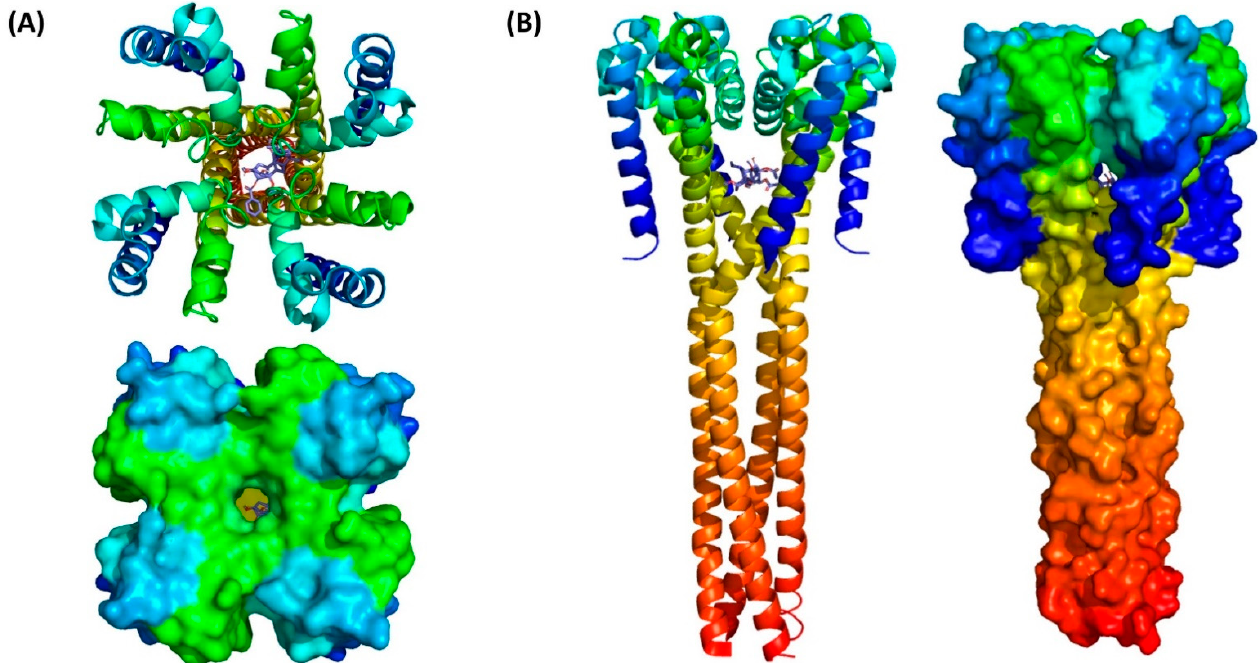
Figure 2. Molecular dynamic simulation results show that aconitine is positioned inside the channel below the four-helix bundle through hydrophobic and hydrogen bonds. ( A ) Top and ( B ) side views of aconitine with voltage-gated sodium ion channels (PDB: 3RVY) illustrated with ribbon diagrams and surface models.